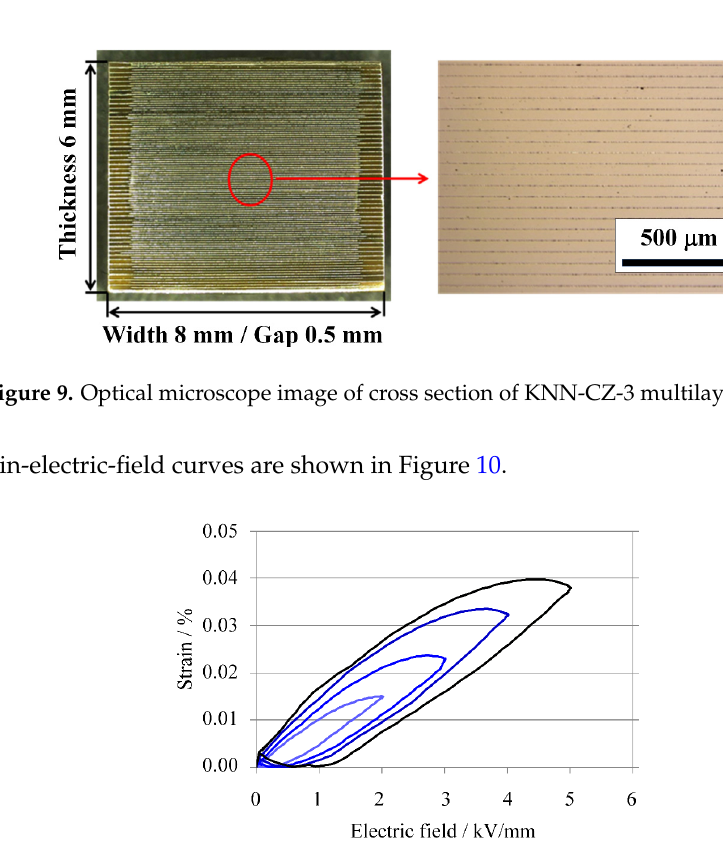
Figure 10. Strain ‐ electric field curves of KNN ‐ CZ ‐ 3 multilayer actuator.